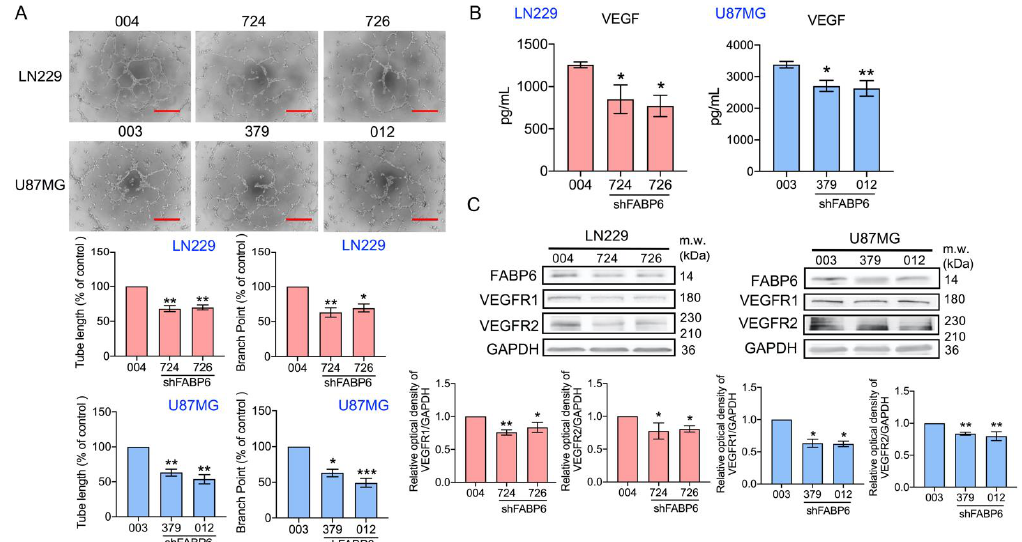
** p < 0.01; *** p < 0.001 compared with the shScramble control group.